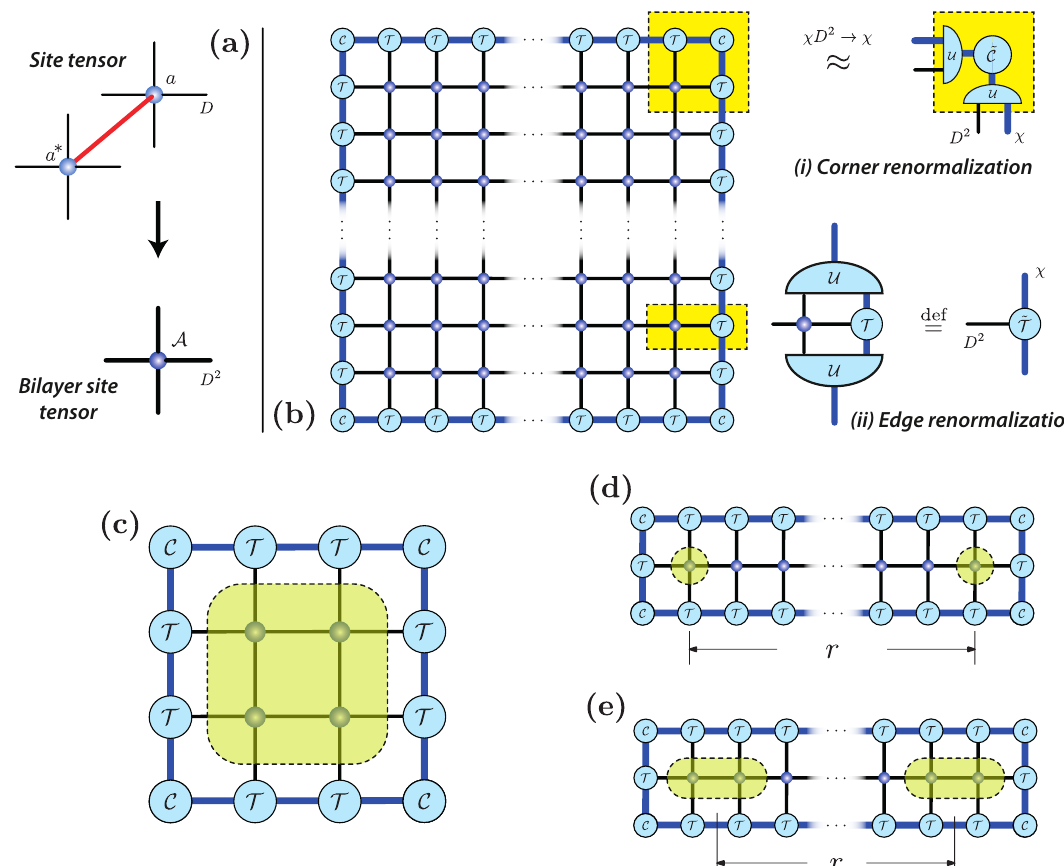
Figure 7: (a) The bilayer site tensor A is obtained by contracting the physical indices (red line) of the site tensor a and its conjugate a ∗ (note that in our case a is real). (b) The two steps CTMRG procedure involving corner and edge tensors. The 2D lattice is contracted starting from its corners (the four corners are identical). The insertion of a site (i) is absorbed by inserting approximate isometries U . The latter are used, in a second step, to absorb the insertion of a site on the edge tensor (ii) (see text for details). (c-e) Geometric setup used to compute energy (c) , spin-spin correlation functions (d) and dimer-dimer correlation functions (e)